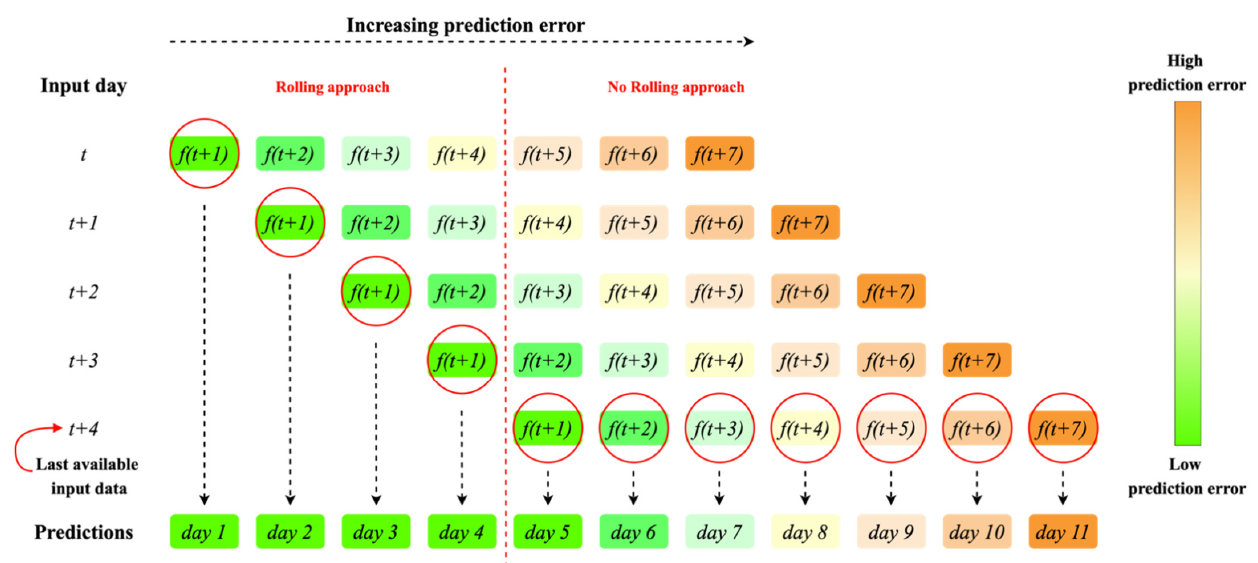
Figure 2. Rolling Approach. The seven-day ahead predictions corresponding to a specific input day, t , are shown in rectangular boxes, whose color determines prediction accuracy. Red circles identify the selected forecasts that will be the output of the framework.